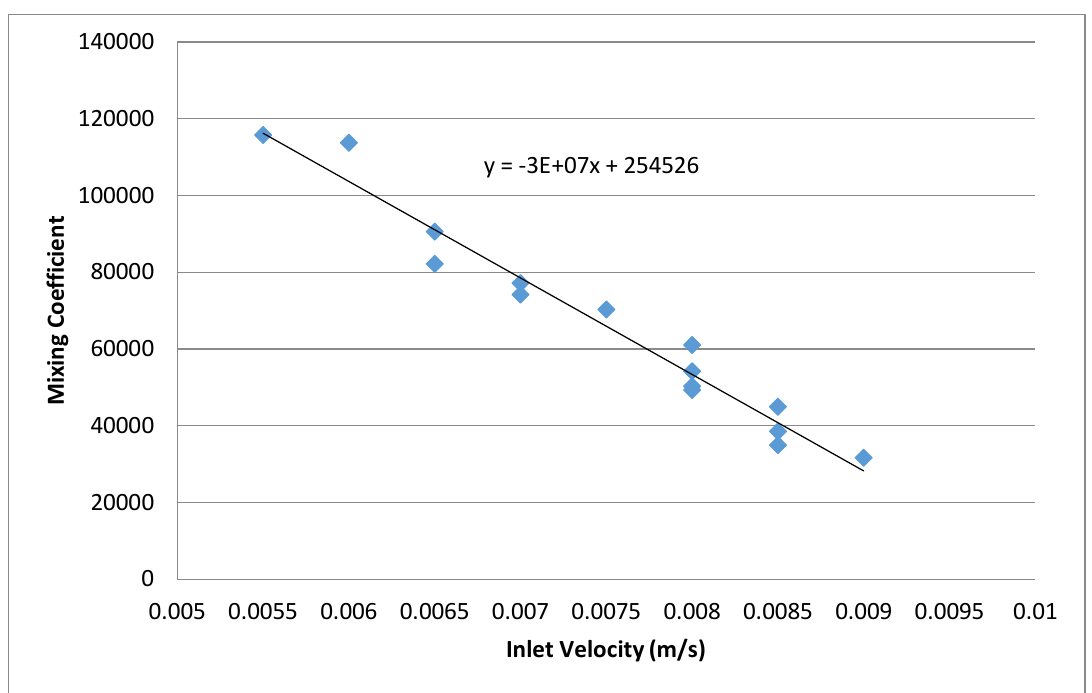
Figure 12. Development of an equation for the mixing coefficient based on inlet velocity.